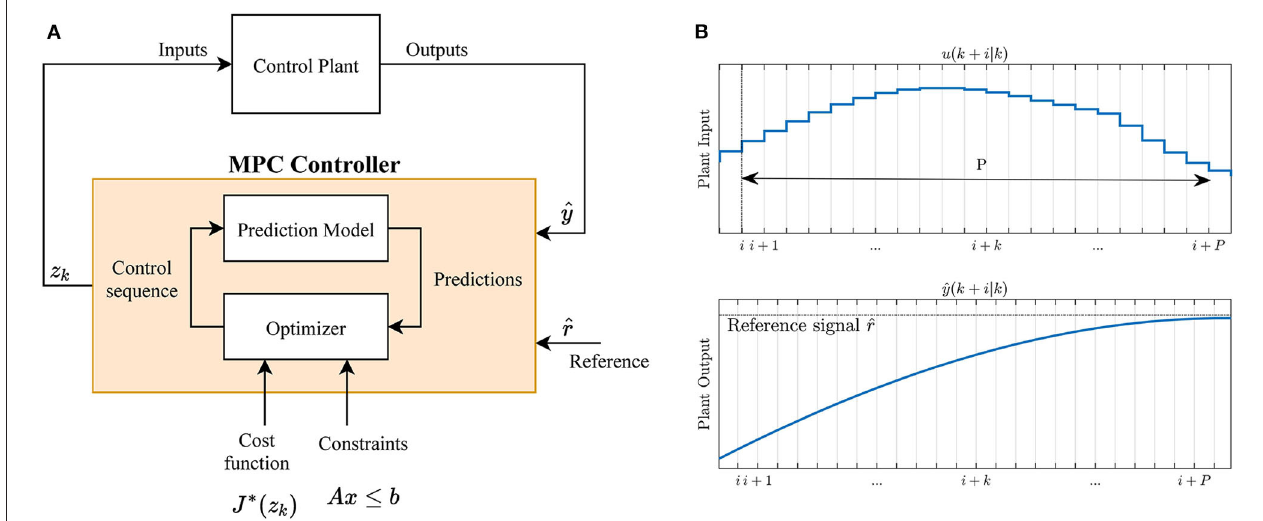
FIGURE 2 | (A) MPC structure of the tracking controller, (B) MPC methodology.